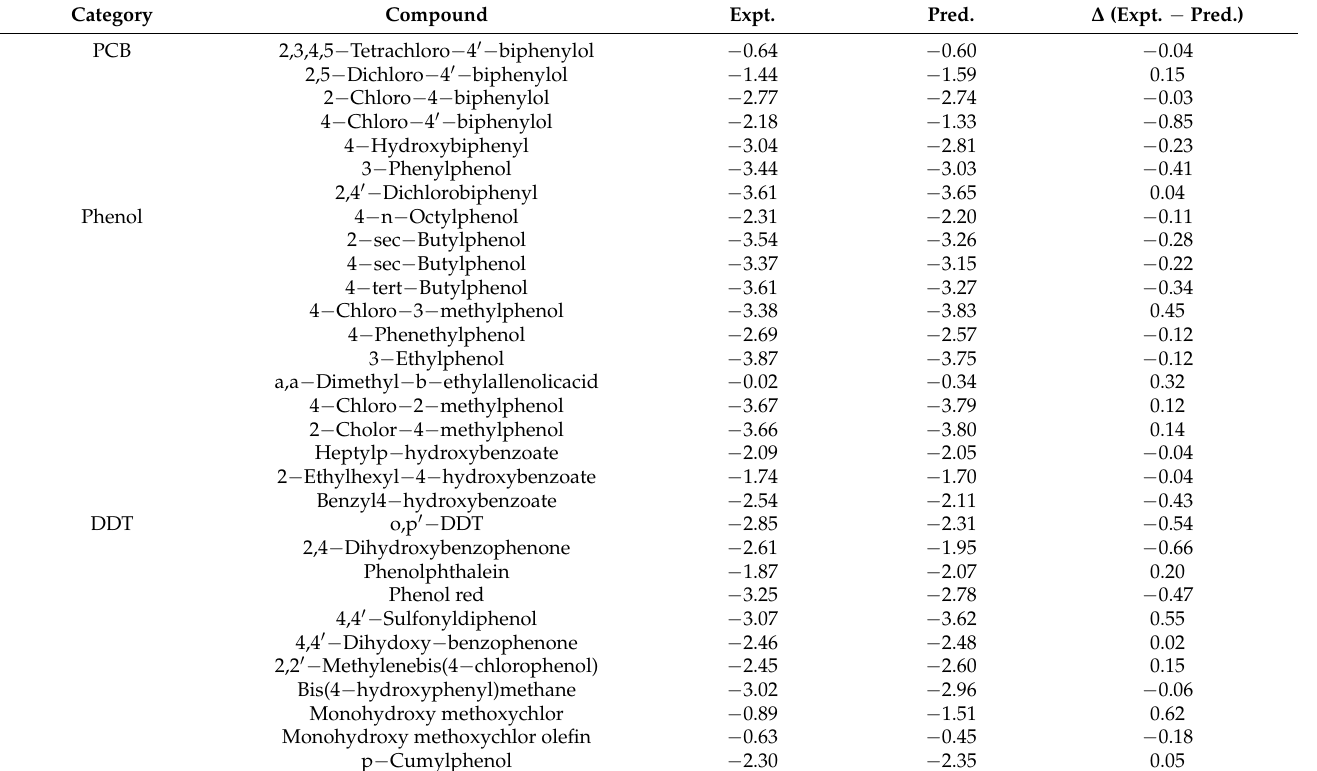
Table 2. The binding affinity (log RBA) of the endocrine disrupting chemicals (experimental, predicted and residual